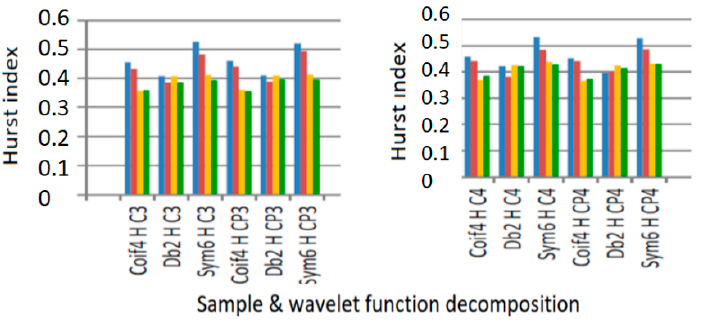
Figure 18. Graphical representation of the results obtained with all three wavelet functions tested for the signals corresponding to the operation of a network with malfunctions and intrusions com- pared to normal operations: ( a ) C3 and CP3 networks and ( b ) C4 and CP4 networks.